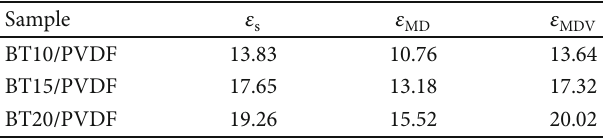
Table 6: Static permittivity of BT/PVDF composites obtained from Equation (2) ( ε ), Equation (3) ( ε s